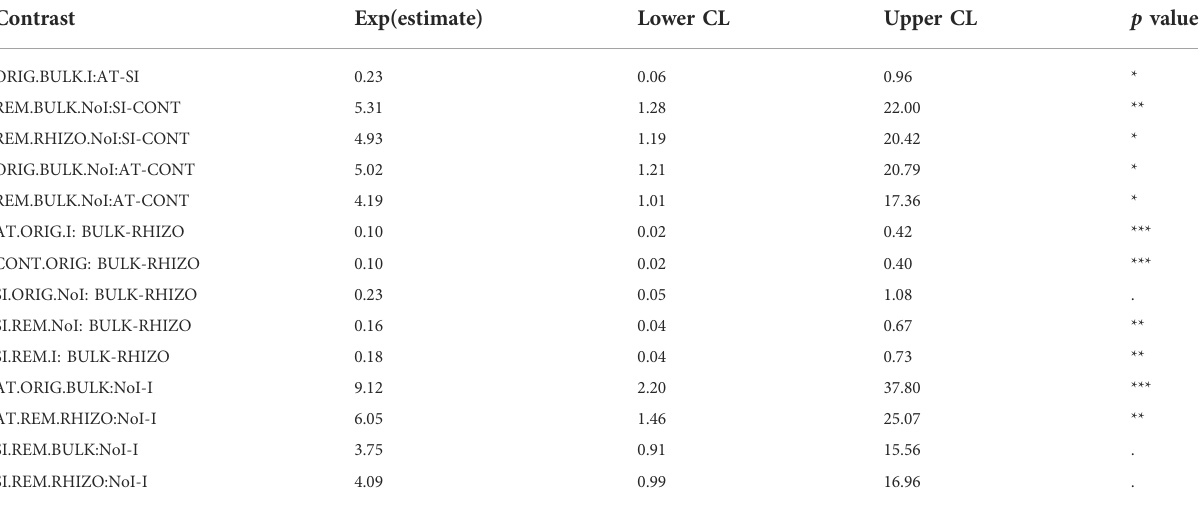
ORIG.BULK.I:AT-SI